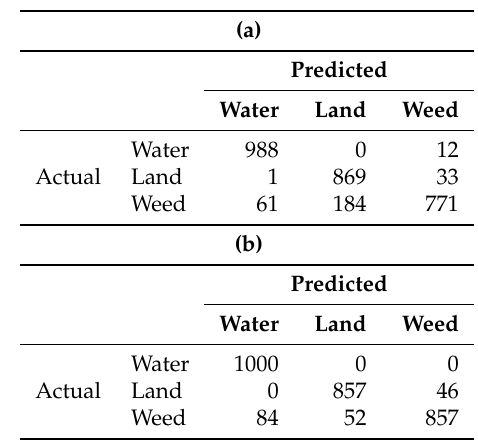
Table 9. Classifier validation error matrices for the WorldView-3 images using automated classifier